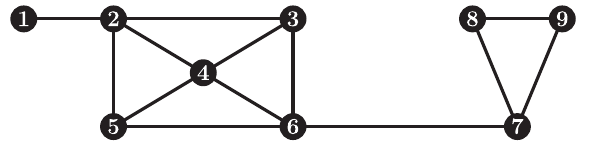
FIG. 2. A small, undirected, nonweighted graph for demon- strating selected centrality measures. It is apparent that node 4 must score high on several centrality measures as it has the most connections. However, nodes 6 and 7 are also important as they form the single link connecting two subnetworks ( f 1 ; 2 ; 3 ; 4 ; 5 ; 6 g and f 7 ; 8 ; 9 g ) together. Their betweenness score should capture this property.